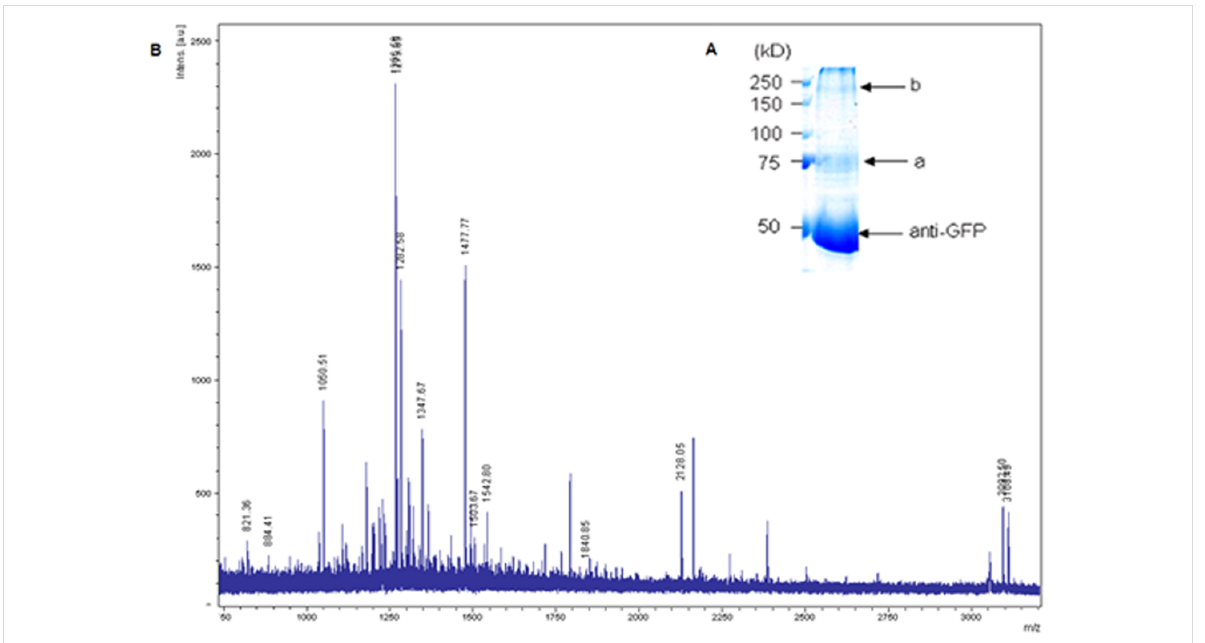
Figure 2: Protein fingerprinting. (A) Coomassie Blue staining of the GAT1/GFP protein from infected Sf 9 cells after immunoprecipitation. Bands a and b (indicated by arrows) were extracted for MALDI–TOF analysis. (B) Mass spectrum of the trypsin digest of band a. The labeled peaks were assigned to either GAT or GFP.